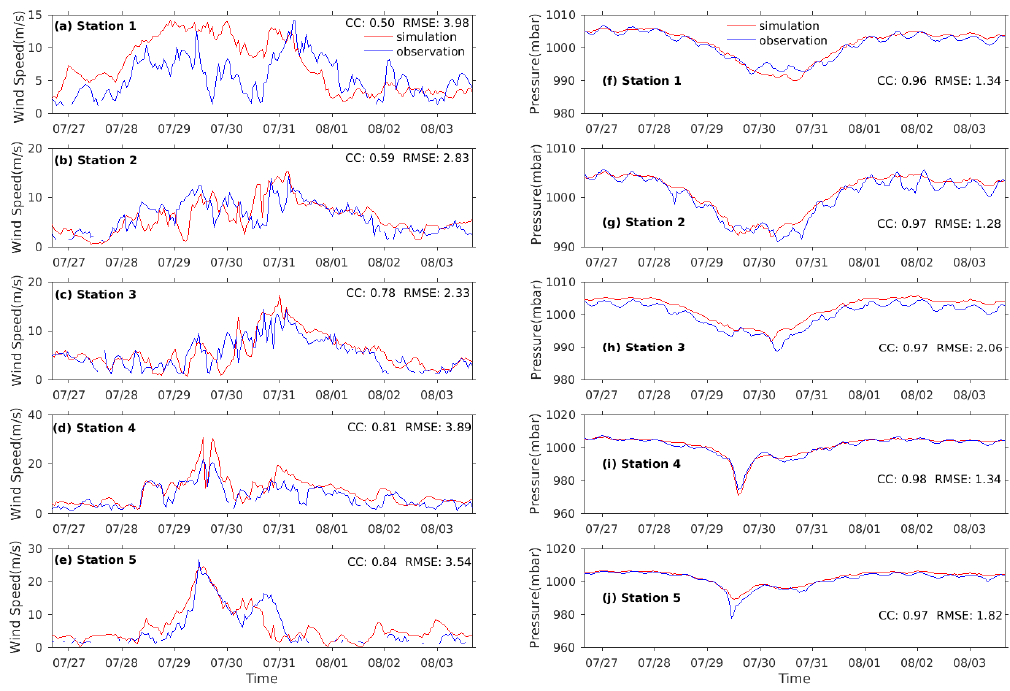
Figure 4. Comparison of time series of WRF simulated (red lines) and buoys observed (blue lines) of wind speed ( a – e ) and air pressure at sea level ( f – j ). CC denotes the correlation coefficient, RMSE is the root mean square error. The positions of stations are shown in Figure 2c.